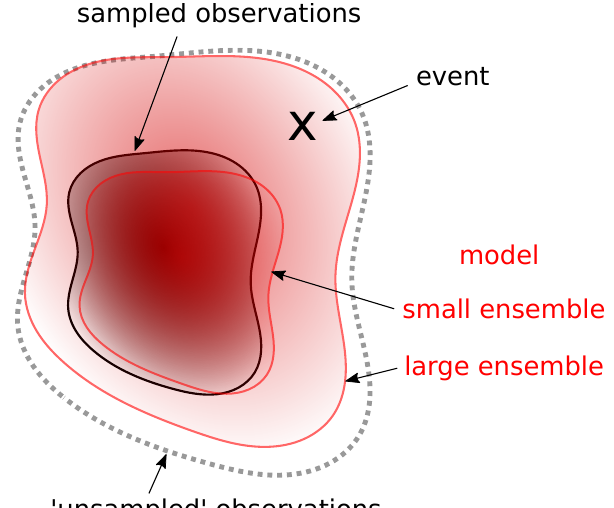
Figure 6. Observed and large ensemble climatologies. The observed climatology is represented by the shaded gray area labeled ‘sampled observations’. With a hypothetical longer sample of observations, the observed climatology could be broader and is represented here as ‘unsampled observations’. The model climatology from a small/large hindcast ensemble is represented by the small/large shaded red regions. A single extreme event ’X’ occurs, which is outside the sampled observation space but inside the large ensemble